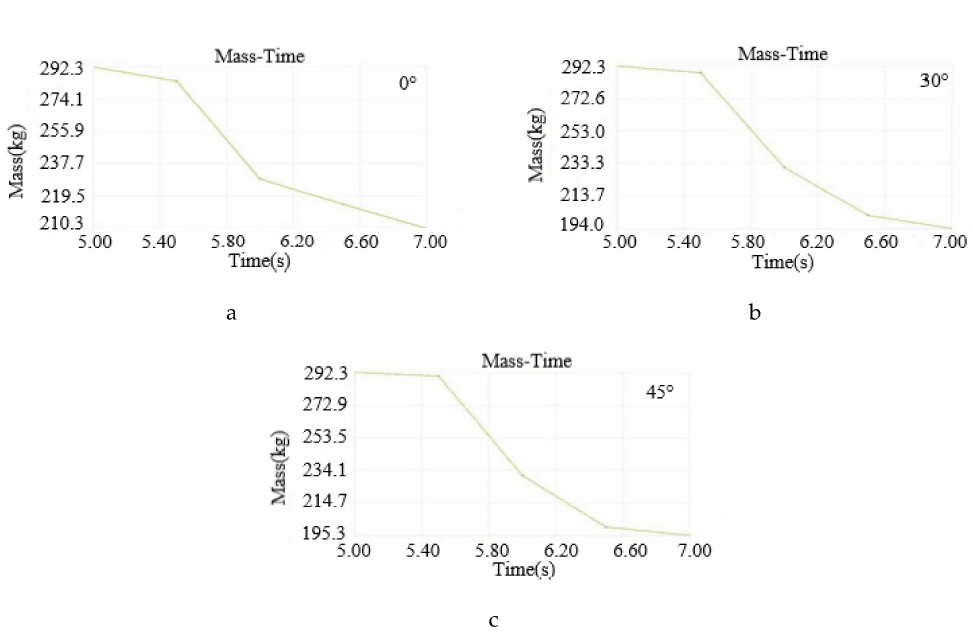
Figure 21. Mass-Time line chart. ( a ) the soil-cleaning situation when the windpipe mouth was pointed at 0 ◦ , ( b ) the soil-cleaning situation when the windpipe mouth was pointing at an angle of 30 ◦ , ( c ) the soil-cleaning situation when the windpipe mouth was pointing at an angle of 45 ◦